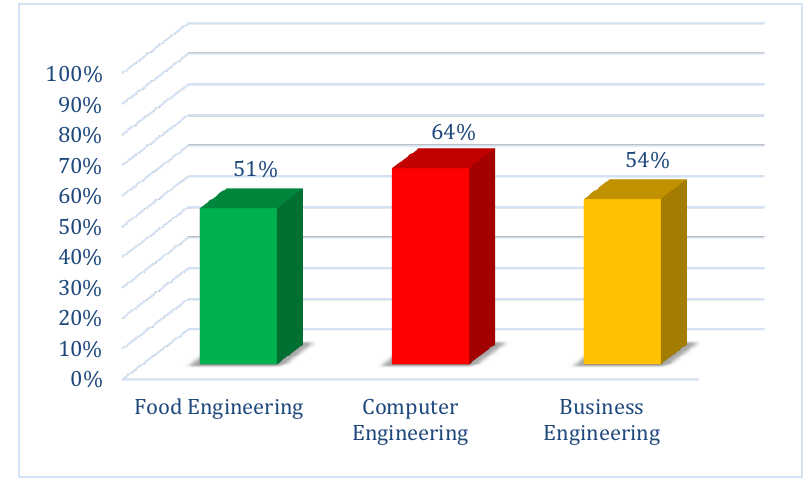
Fig. 2. Levels of performance by